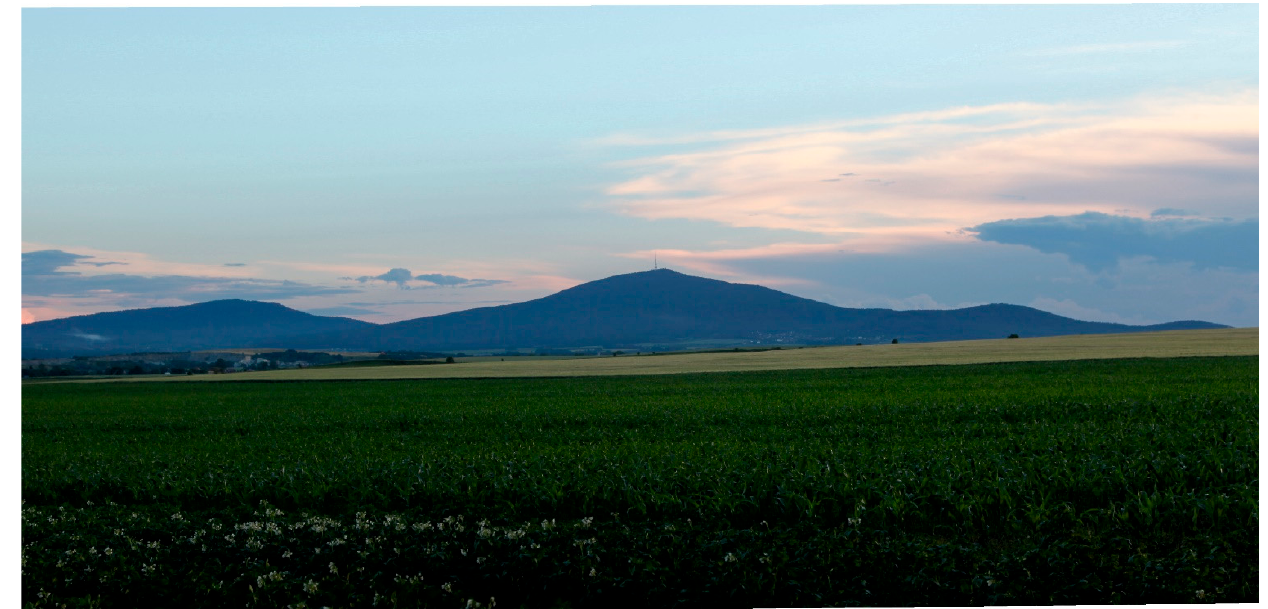
Figure A2. Paleonunatak— Ś l ęż a Mountain (718 m n.p.m.).